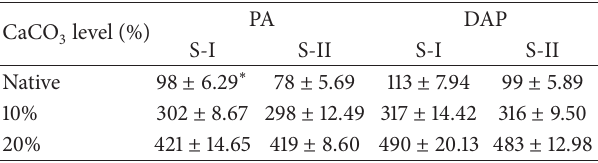
Table 4: Quantities of P soil solution